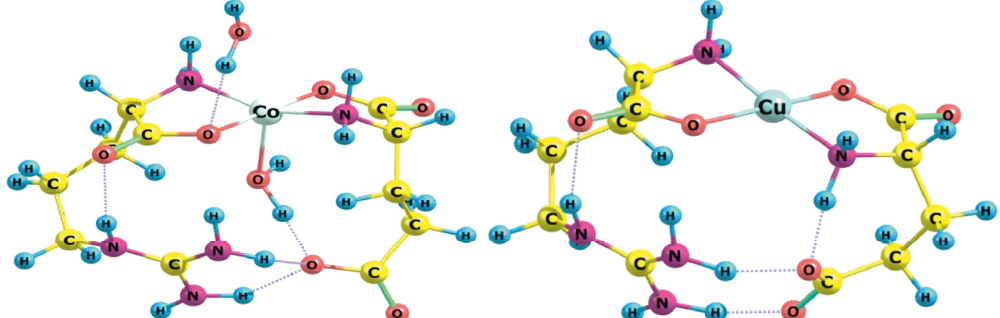
Figure 1: The optimized structure of Co(II) and Cu(II) complexes (dotted lines represent H bonding) indicating the coordination sites of the ligands, which result in the most stable orientation. Ni and Zn complexes have geometries similar to Co complexes.